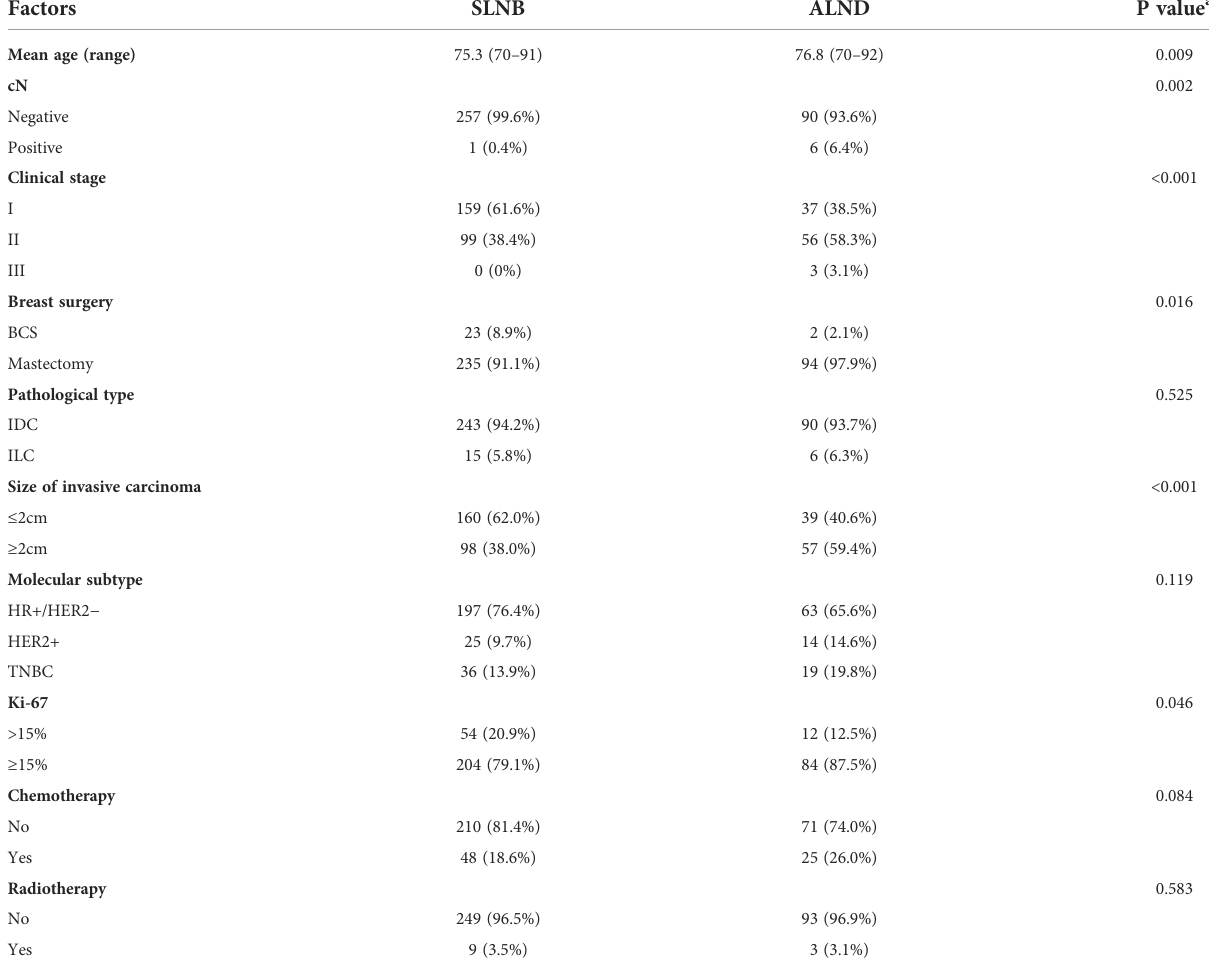
TABLE 3 Clinicopathological characteristics of pN0 cases according to axillary